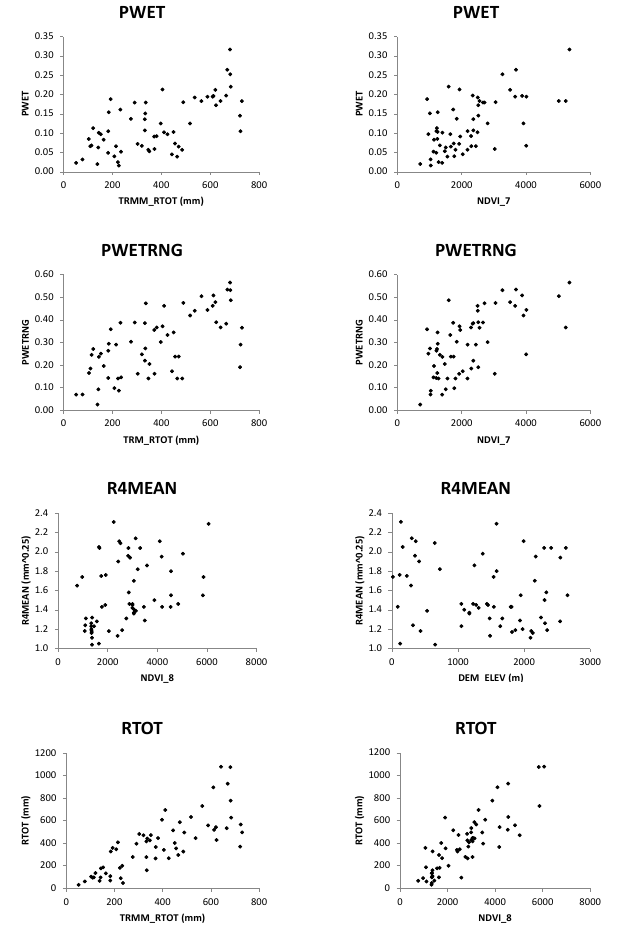
Figure 6 Example relationships between daily precipitation parameters for Network A and selected predictor variables: TRMM(V7), NDVI, and ELEV.